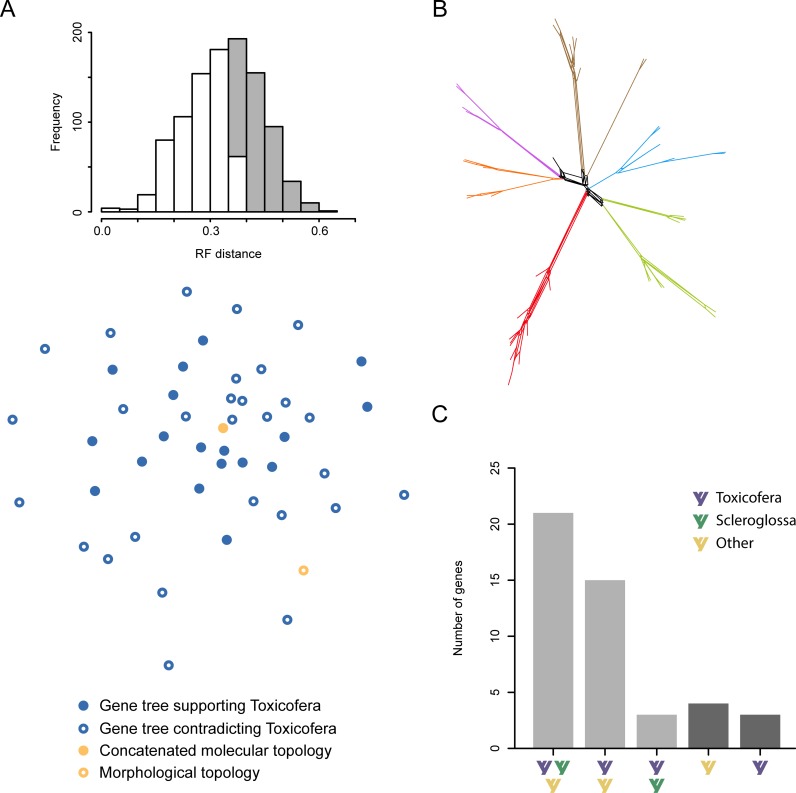
Incongruence in the inference of the lizard tree based on individual genes.(A) Projection of topological differences among gene trees on a two-dimensional treespace. The histogram shows the distribution of pairwise Robinson-Foulds (RF) distances among gene trees, with grey bars representing the fraction of distances larger than the that between the morphological and concatenated molecular topologies (yellow circles). (B) Supernetwork condensing gene tree incongruence. Clades are colored as in Fig 1. Most topological variability is restricted to the backbone (black branches), characterized by different resolutions (reticulations) found at a low frequencies (C) Histogram showing the types of topologies found in the confidence set of trees for all genes. Light grey bars show numbers of genes for which the confidence set contains more than one option (85%), revealing insufficient levels of phylogenetic signal to distinguish among competing resolutions of the lizard backbone clades.